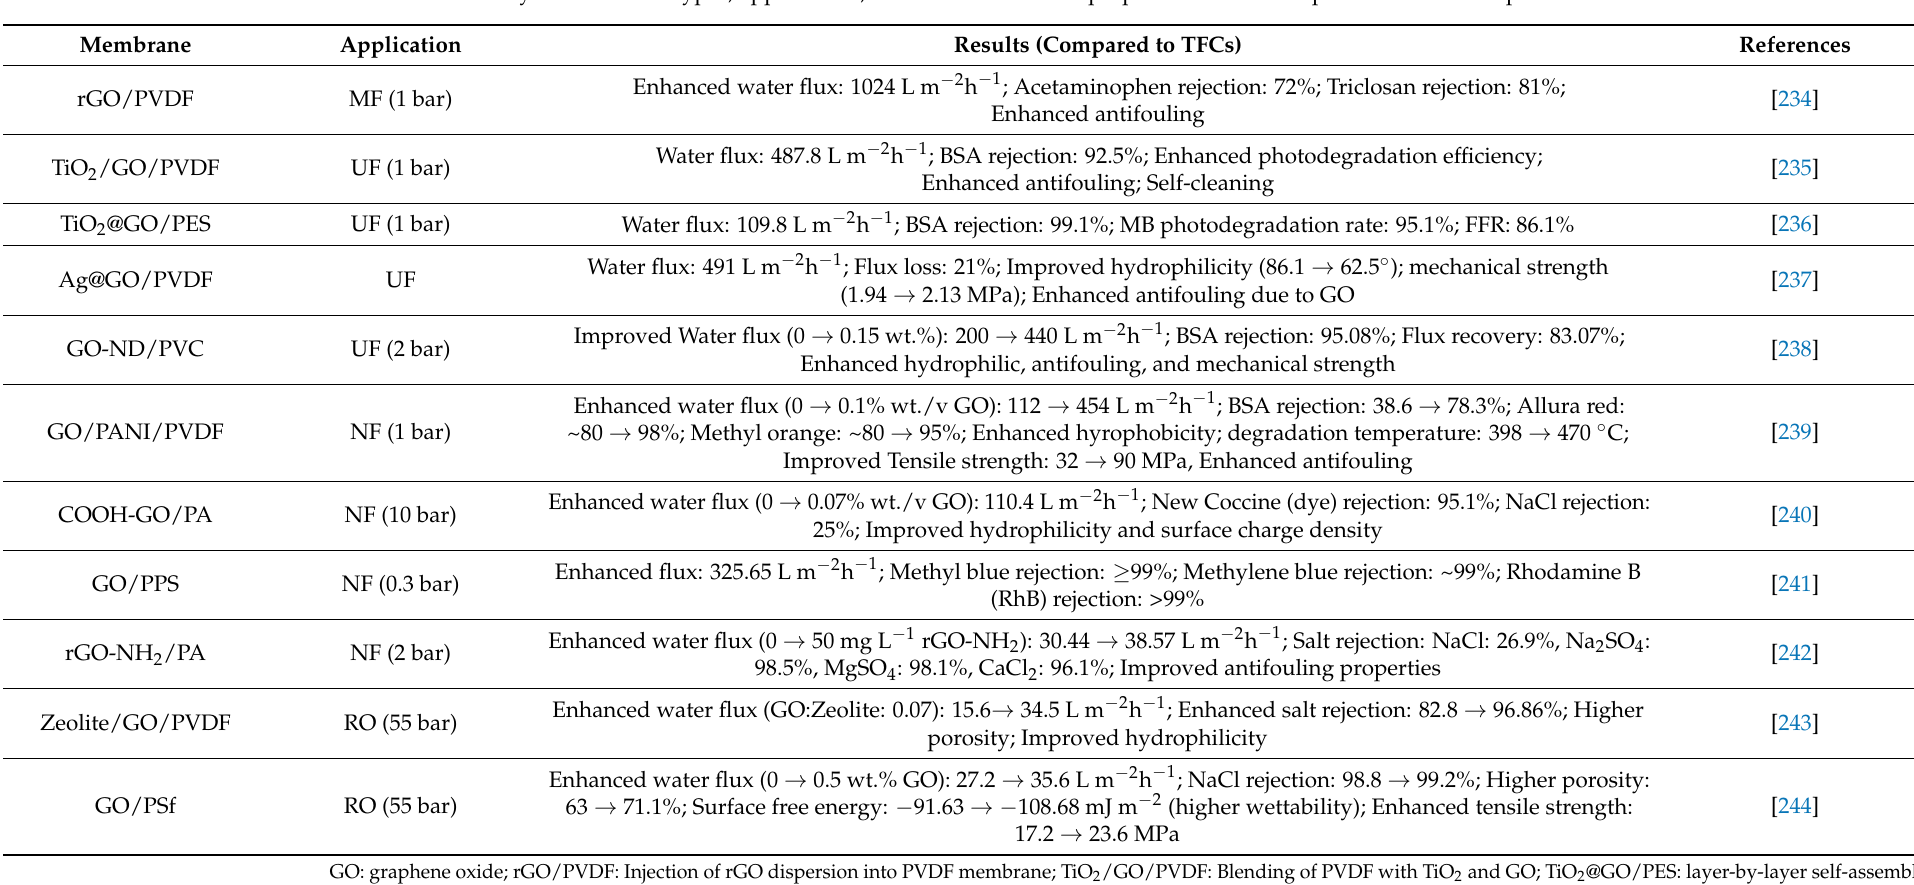
Table 4. A summary of membrane types, applications, and enhancements in properties of nanocomposites due to incorporation of